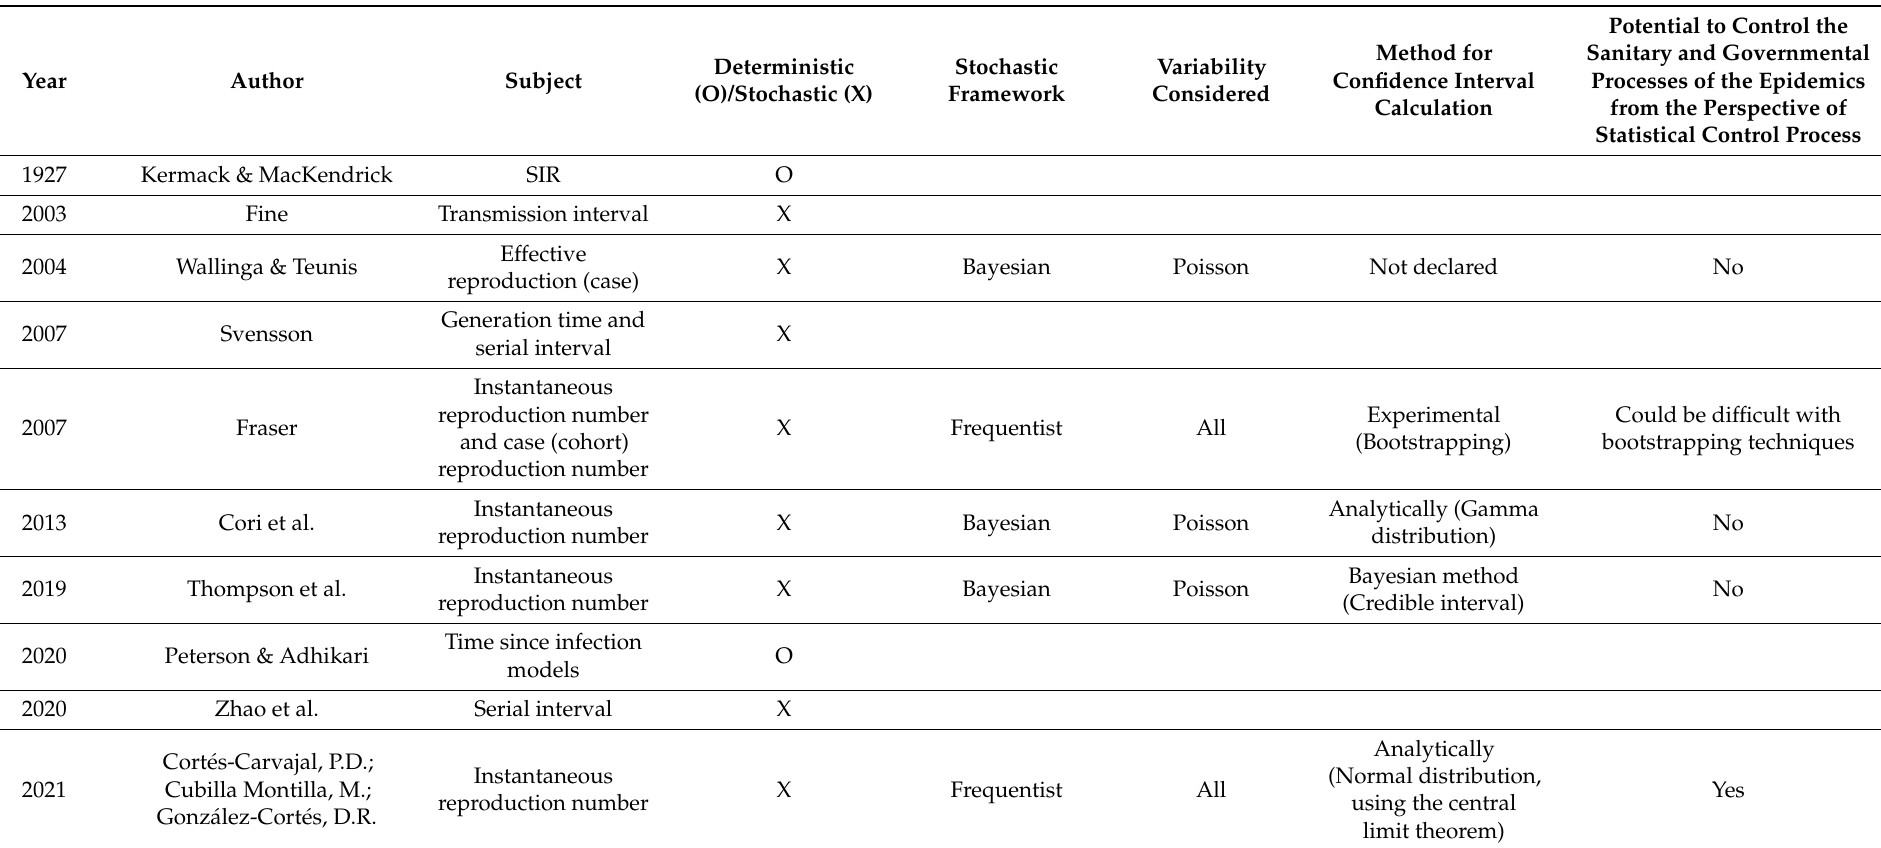
Table 1. Comparative table of investigations regarding to epidemics process models. The blank cells mean the criterion was not